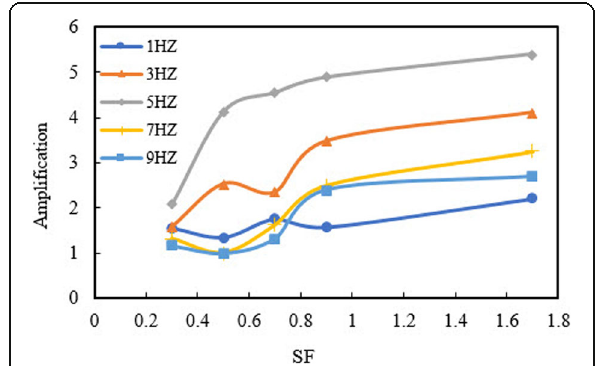
Fig. 10 Effect of SF on amplification of crest-to-toe strain: ( a ) Chi- Chi; ( b )